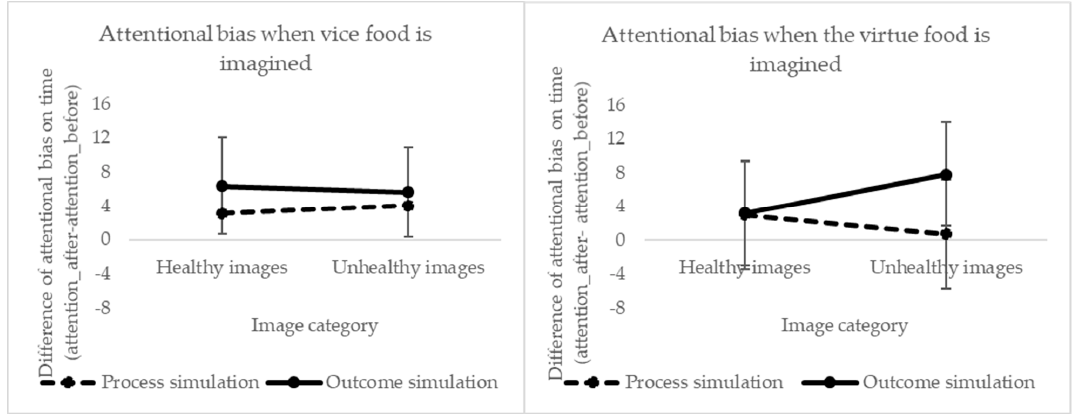
Figure 4. Difference between before and after simulation, when people imagined the vice and the virtue food product, across the picture food category.